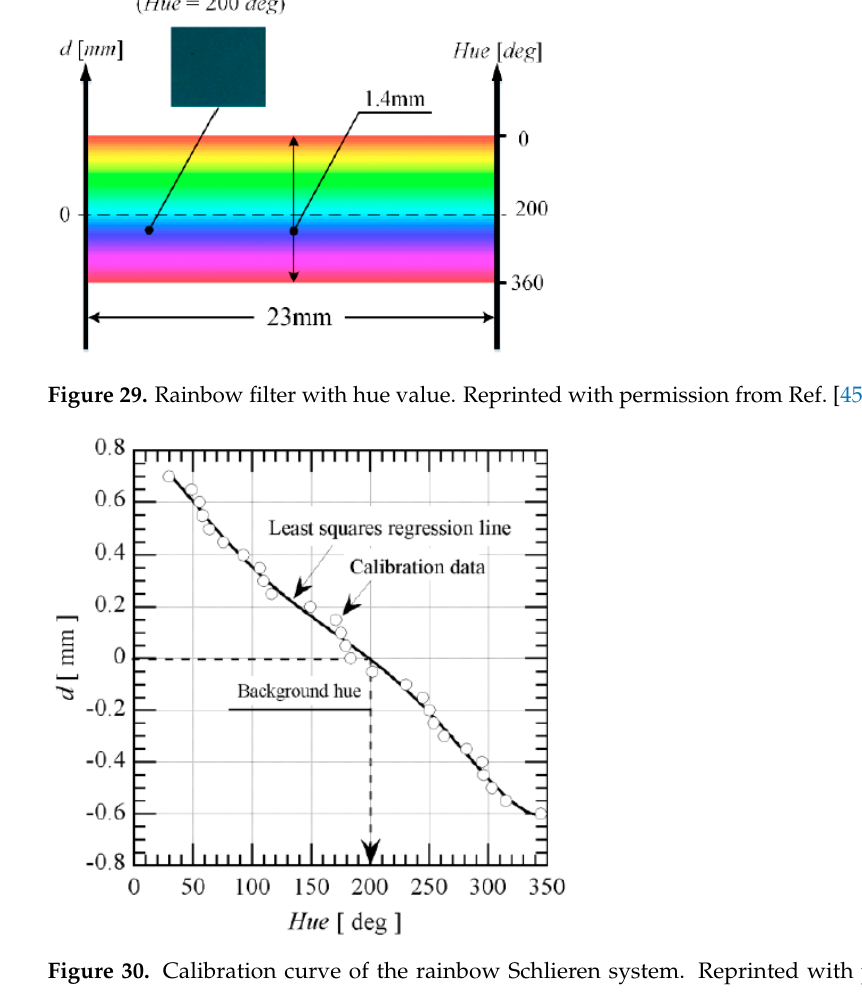
Figure 32. Rainbow Schlieren post-processing density contour plot. Reprinted with permission from Ref. [45] (2018). Figure 33. Theoretical/experimental data comparison for the rainbow Schlieren. Reprinted with permission from Ref. [45] (2018). Background oriented Schlieren (BOS) is the digital version of Schlieren imaging. In the BOS layout, some random points are captured in the background of the flowfield with a high-resolution camera. The BOS technique evaluates the apparent displacement caused by the aero-optical effects of a dot pattern through a camera. The presence of an intermediate index gradient due to compressibility effects or hot flow is the cause of the aero-optic effects. The 3D density field will be estimated through the apparent displacement of the pattern and the light ray deviation maps that have been obtained from a given number of points of view. At NASA’s Glenn Research Centers Altitude Combustion Stand (ACS), many tests are carried out, implementing the background oriented Schlieren, BOS, the technique to visualize the plume of a small rocket engine under altitude testing conditions, using nitrogen as the exhaust gases simulant [46].